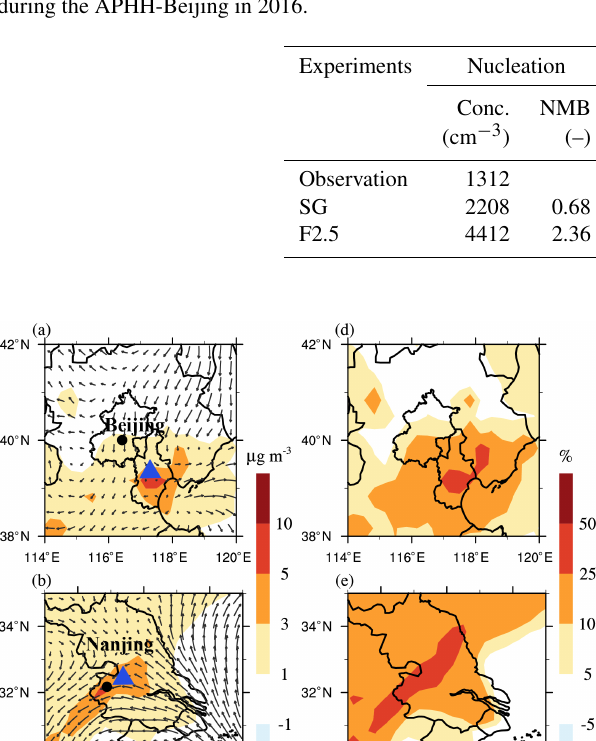
Table 5. Mean number concentrations (“conc.”) of the observations and simulations and the NMB for different modes at the site in Beijing during the APHH-Beijing in 2016.